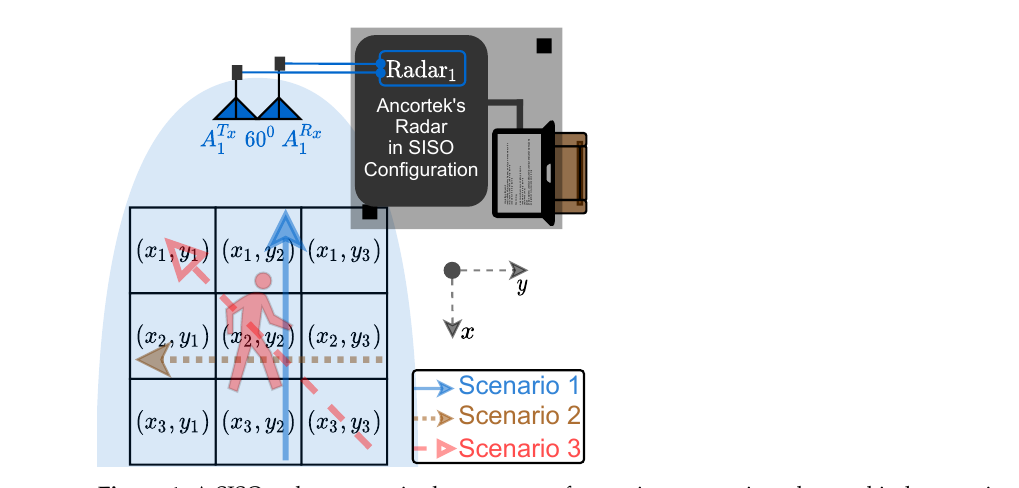
Figure 1. A SISO radar system in the presence of a moving person in a cluttered indoor environment.